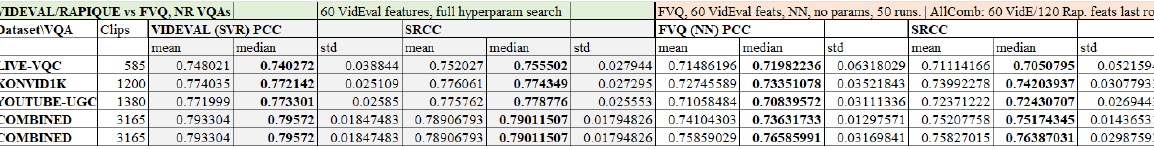
Figure 4. Simulation results in no reference testing, using several large no reference user generated content databases. Comparisons are to a state-of-the-art VIDEVAL algorithm, where we used the same 60 features, but a different regressor (a fixed NN architecture) and where we reduced complexity by avoiding any hyperparameter search. For the last row, we used 60 VIDEVAL features, and 120 RAPIQUE features (total of 180) to obtain our best results with the NN regressor, and no parameter search. The main value of our approach was to expedite training processing in modern GPU-enabled compute architectures. In our tests, the combined training and testing for 50 cycles ran at least 20X faster than the SVR with full parameter search in a Google Colab tensorflow computation. We also hope to be able to reach state-of-the-art results in the near future, by combining additional powerful and salient features in the